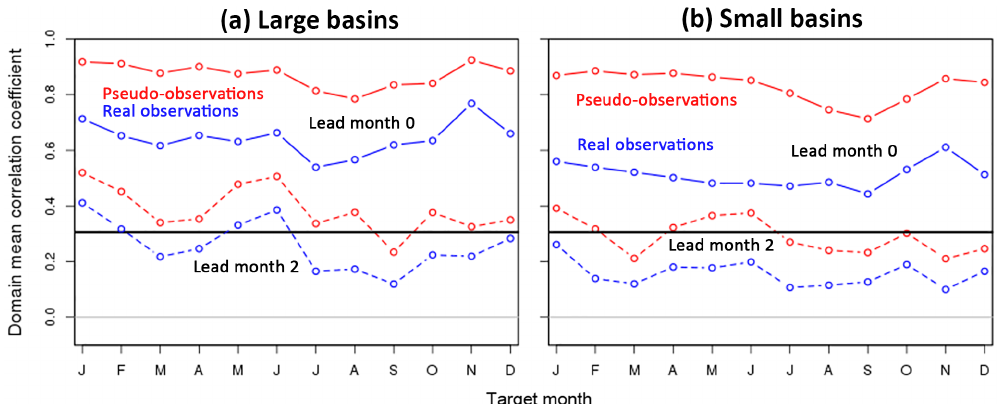
Figure 8. Comparison between verification of discharge with pseudo- (red) and real (blue) observations in terms of the annual cycle of the domain-mean R . The horizontal line at 0.31 is the threshold of significance for a single cell. Results are shown for cells representing large basins (a) and cells representing small basins (b) . Both panels depict cycles for lead months 0 and 2 only.